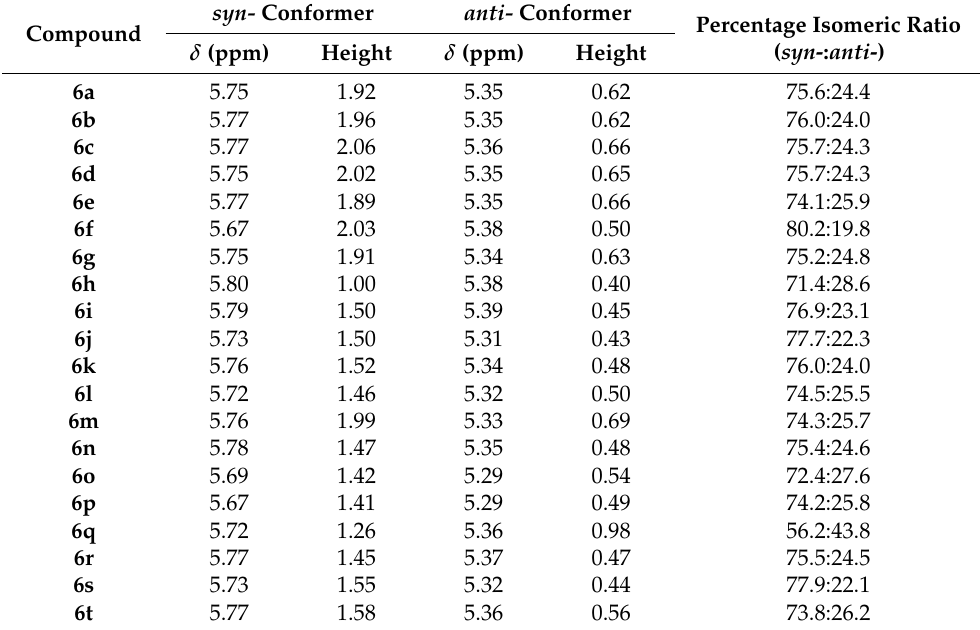
Compound Table 2. Ratio of conformers of 6 ( a – t ) in DMSO- d 6 *.